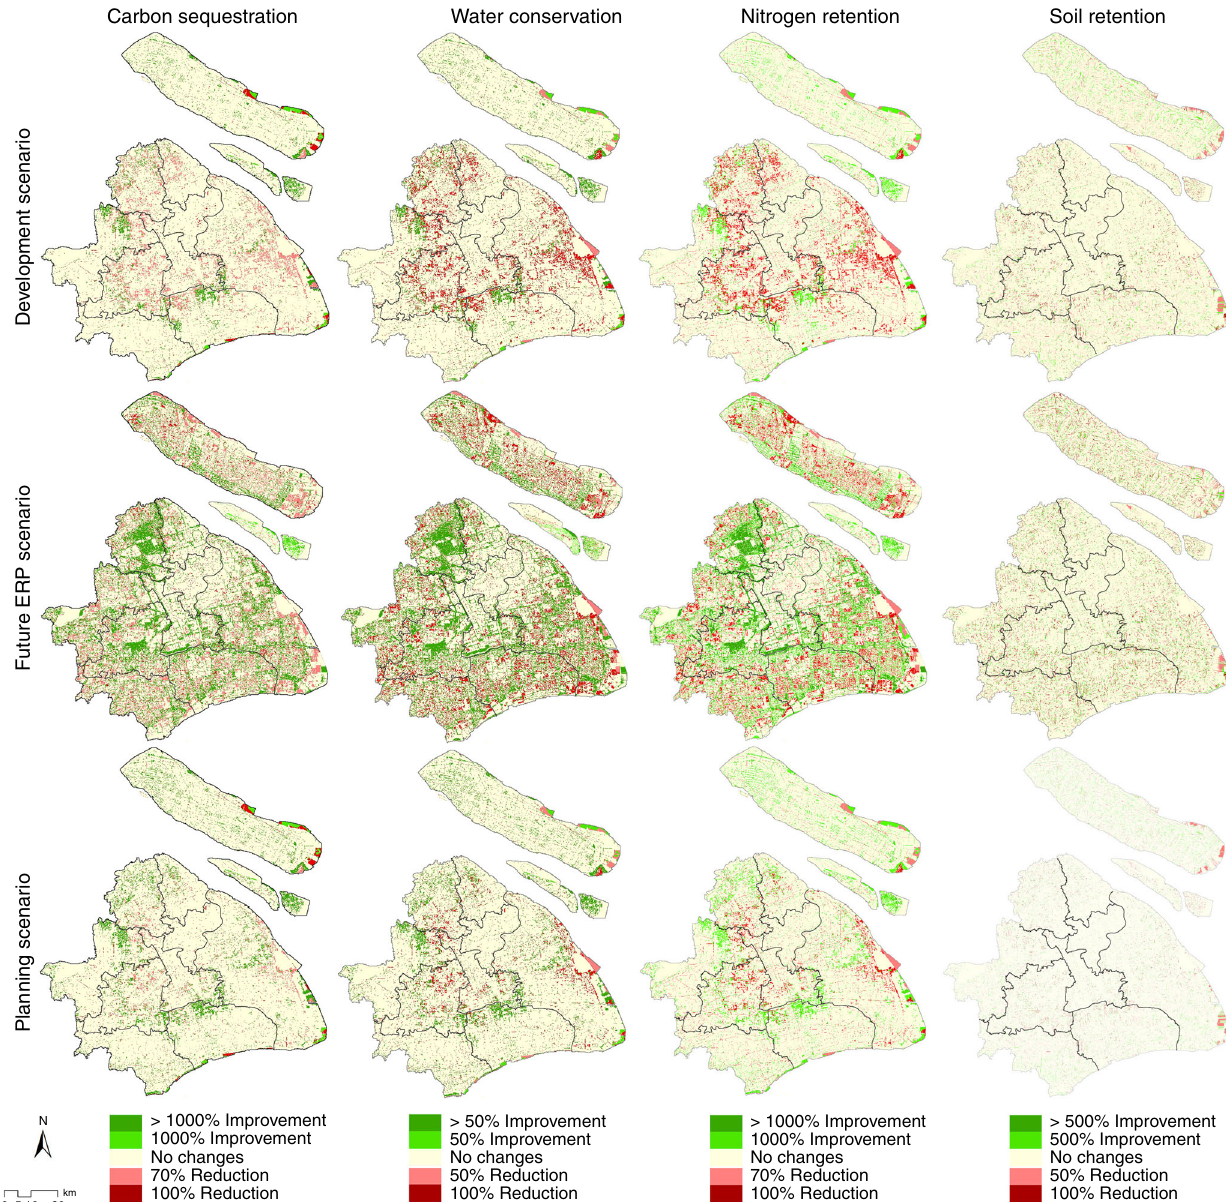
Fig. 7 Performance of the Ecological Redline Policy. The horizontal panels represent the change in each ecosystem service relative to the baseline scenario (i.e., scenario 1), and the vertical panels represent the performance of the different future scenarios. The data show the percentage of improvement (green) or reduction (red) of each ecosystem service in each scenario relative to the baseline scenario. The maps in this fi gure were made by the author in ArcGIS software for use in this